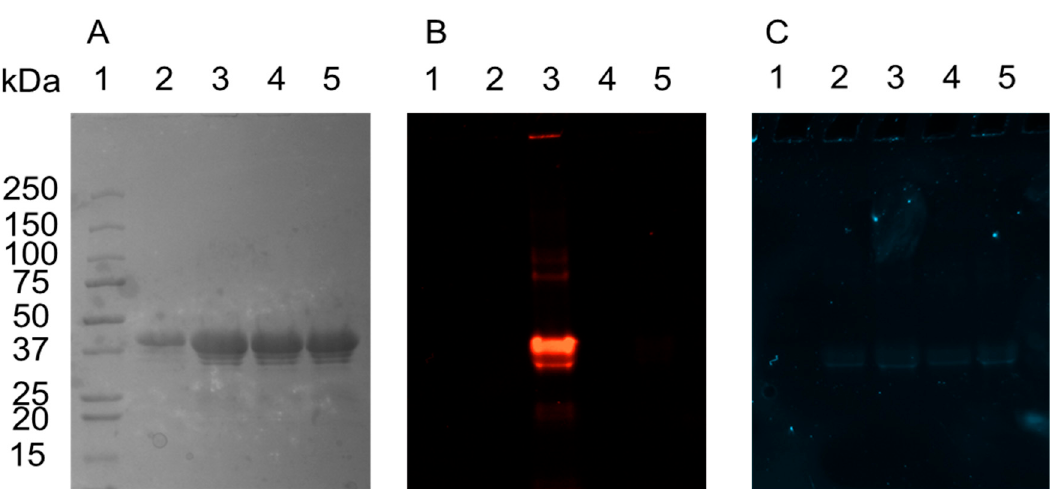
Figure 2. SDS PAGE gel of protein conjugates obtained after first reacting 6 with MBP-dC10* by the FlARe reaction followed by the conjugation of rhodamine B azide (RhB-N 3 ) to MBP-dC10* through 6 using CuAAC. A ) Coomassie stained gel showing MBP-dC10* bands. B ) Unstained gel excited with Green Epi Illumination and imaged using a 605/50 filter. C ) Unstained gel excited with Blue Epi Illumination and imaged with a 530/28 filter. Lanes: 1) Pre-stained protein standards 2) MBP-dC10* 3) MBP-dC10* reacted with 6 and then conjugated to RhB-N 3 4) MBP-dC10* reacted with 6 5) MBP-dC10* incubated with RhB-N 3 under CuAAC conditions.